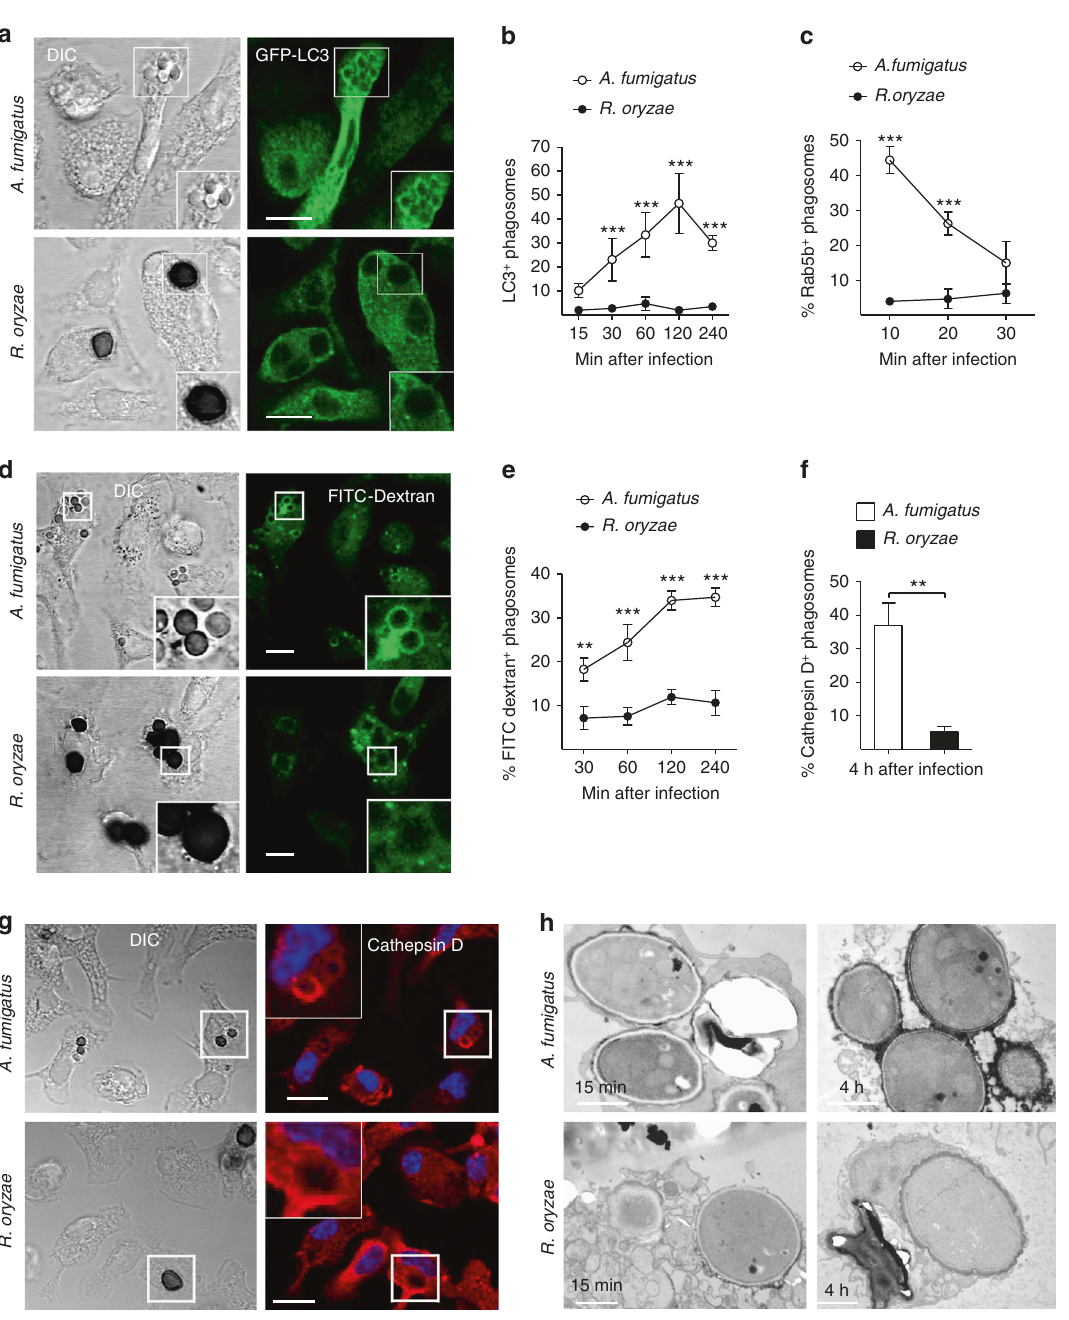
Fig. 3 Rhizopus conidia induce phagosome maturation arrest in BMDMs. a , b BMDMs from GFP-LC3 mice were infected at different time points with live conidia of A. fumigatus or R. oryzae at an MOI 3:1 (effector:fungal cells). At the indicated time point, cells were fi xed and analyzed by confocal microscopy. Representative fl uorescence images are presented in a . Bar, 5 µ m. Data on quanti fi cation of LC3 + phagosomes are presented as mean ± SEM of fi ve independent experiments in b . c BMDMs from C57BL/6 (B6) mice were infected as in a . Cells were fi xed at the indicated time point and stained for Rab5B. Data on quanti fi cation of Rab5 + phagosomes are presented as mean ± SEM of three independent experiments. d , e BMDMs were pre-loaded with FITC- Dextran, infected as in a , and phagolysosomal fusion was assessed at the indicated time point based on acquisition of FITC-Dextran in the phagosome. Representative fl uorescence images are shown in d . Bar, 5 µ m. Data on quanti fi cation of FITC-Dextran + phagosomes are presented in e as mean ± SEM of three independent experiments. f , g BMDMs were stimulated as in a , cells were fi xed and stained for the lysosomal protein marker Cathepsin D. Data on quanti fi cation of Cathepsin D + phagosomes are presented as mean ± SEM of three independent experiments in f , while representative fl uorescence images are shown in g . Bar, 5 µ m. h Representative electron microscopy of acid phosphatase, a lysosomal enzyme marker of phagolysosomal fusion (shown as dark color on the phagosome membrane) in 15 min and 4 h phagosomes containing A. fumigatus or R. oryzae conidia. *** P < 0.0001, ** P < 0.01, Mann – Whitney test. Bar, left upper and lower panels, 1 µ m; right upper panel, 0.5 µ m; right lower panel, 2 µ